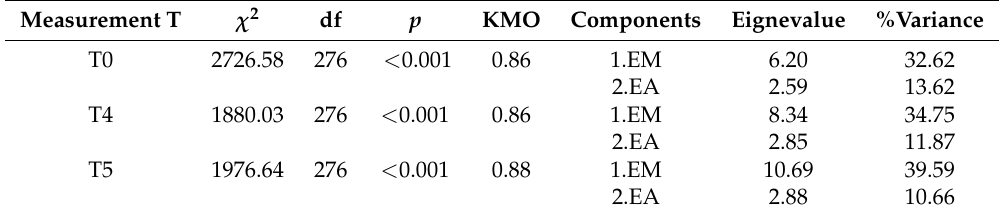
Table 4. Coefficients of Bartlett sphericity tests, KMO, eigenvalues, and percentage of explained variance for solutions with two